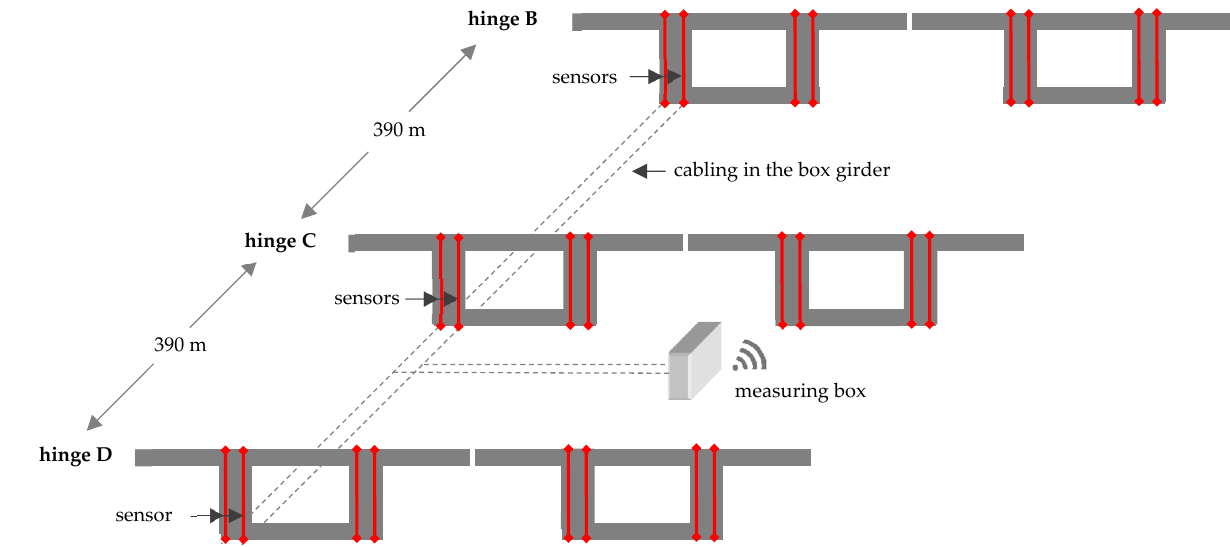
Figure 3. Set-up of the strain and temperature measurement.